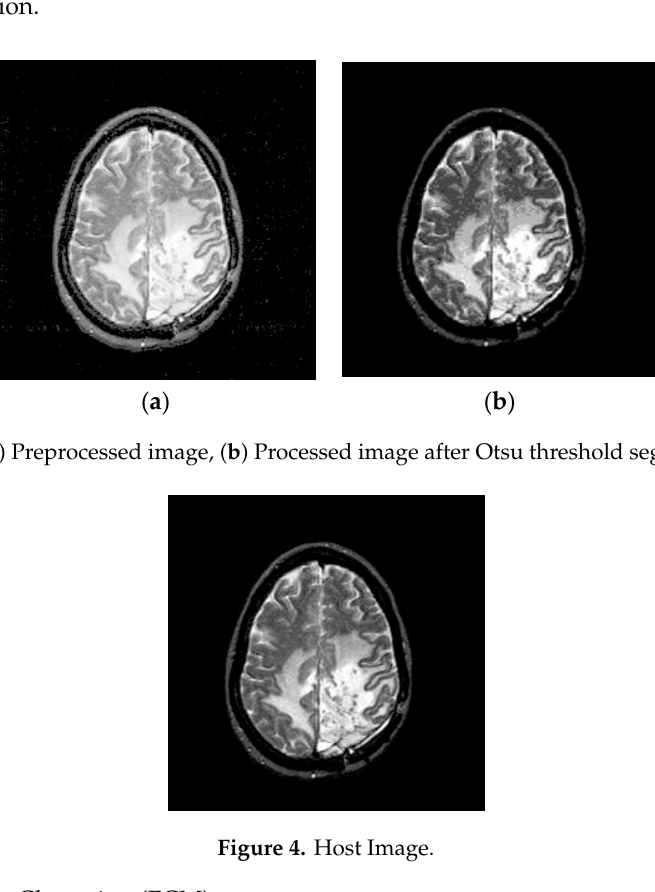
Figure 2. The SMQT as a binary tree of the mean quantization unit (MQU).